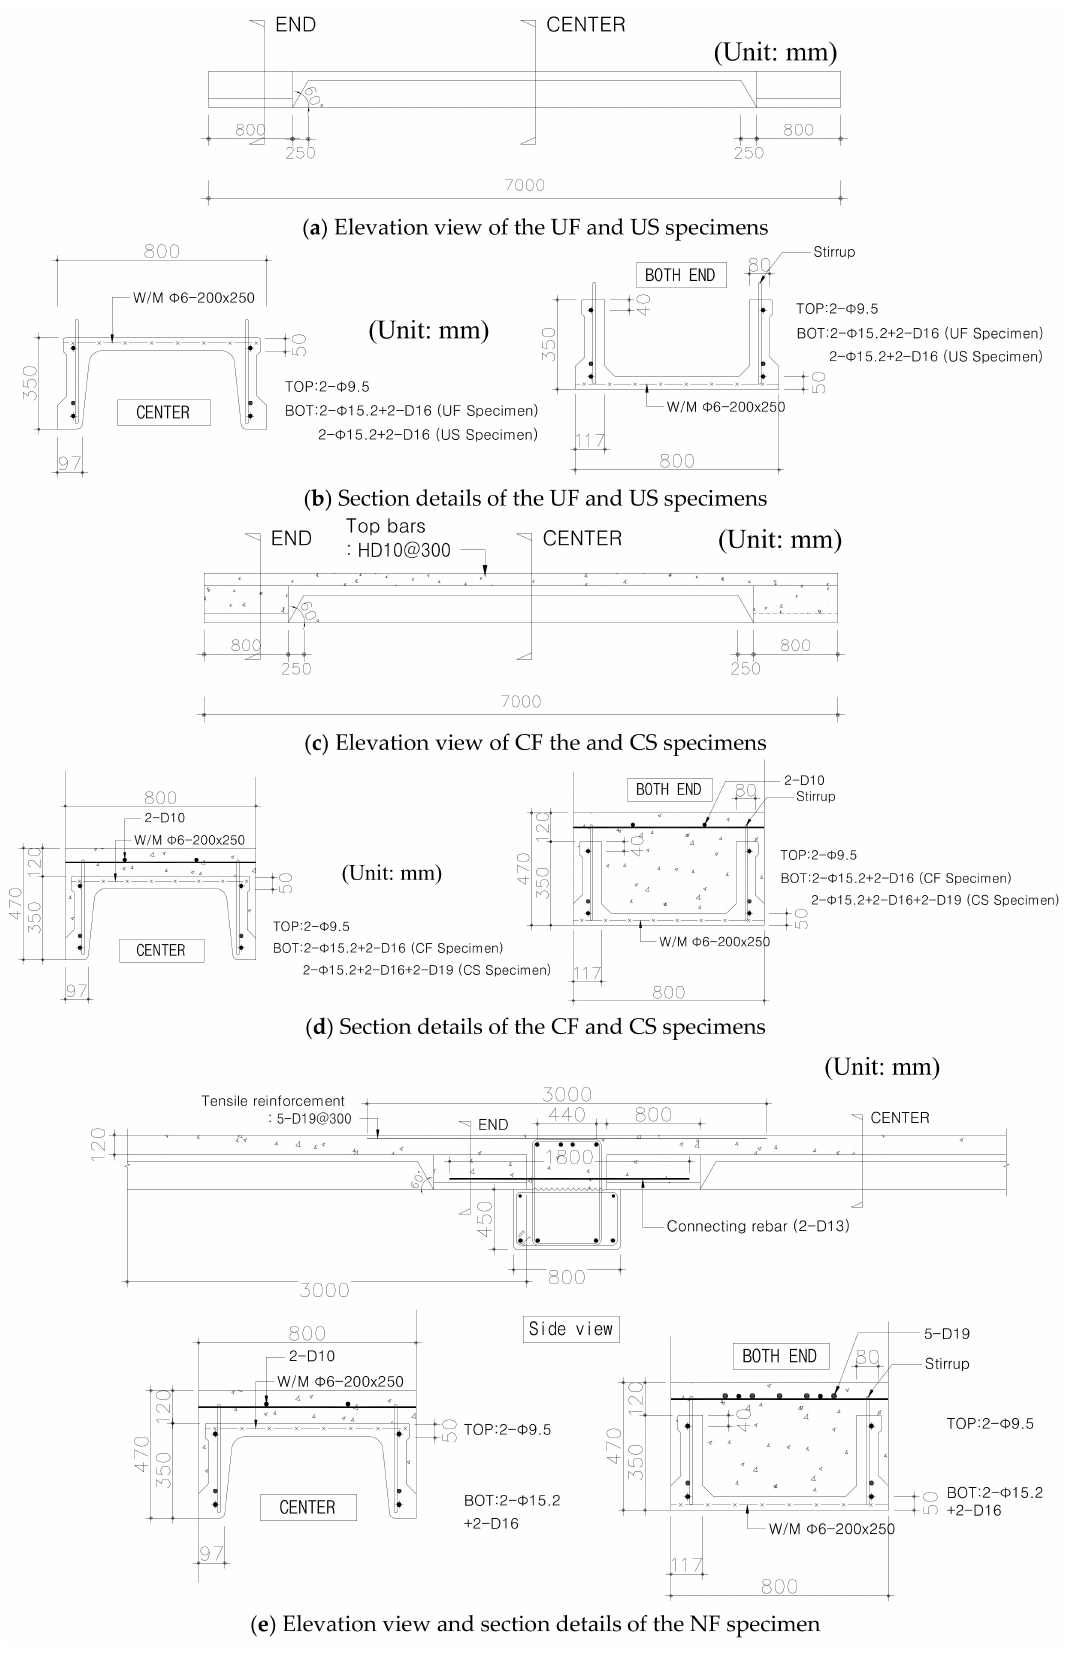
Figure 5. Section details of the specimens (Unit: